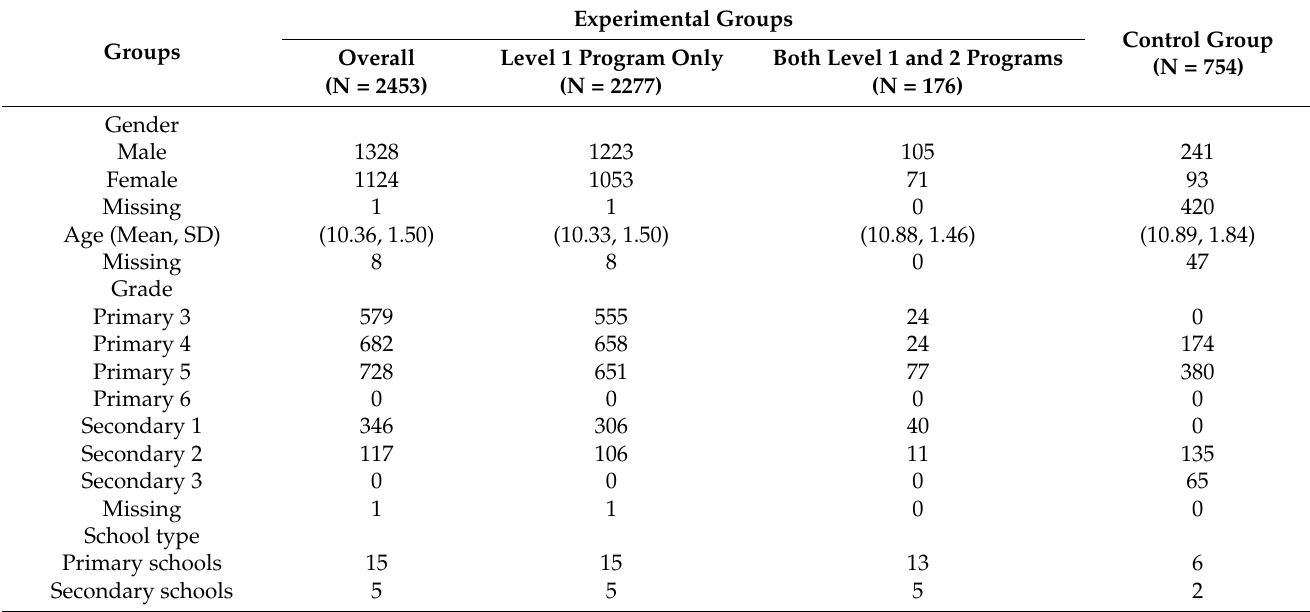
Table 1. Demographic information of the participants in different